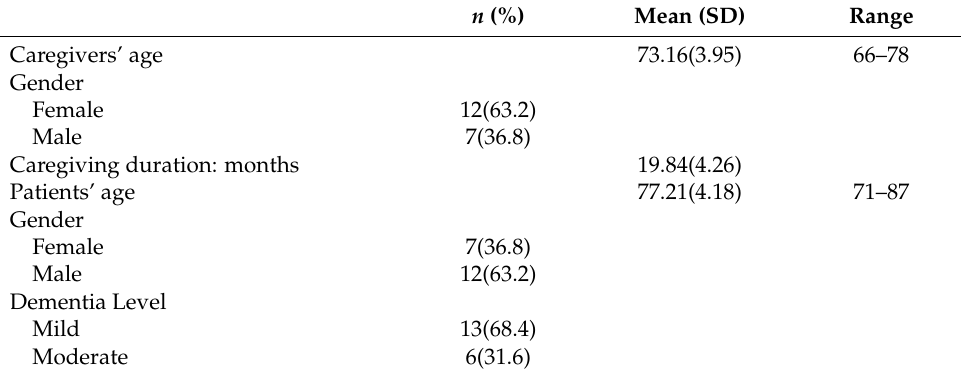
Table 2. Characteristics of caregivers of charges with Alzheimer’s disease.